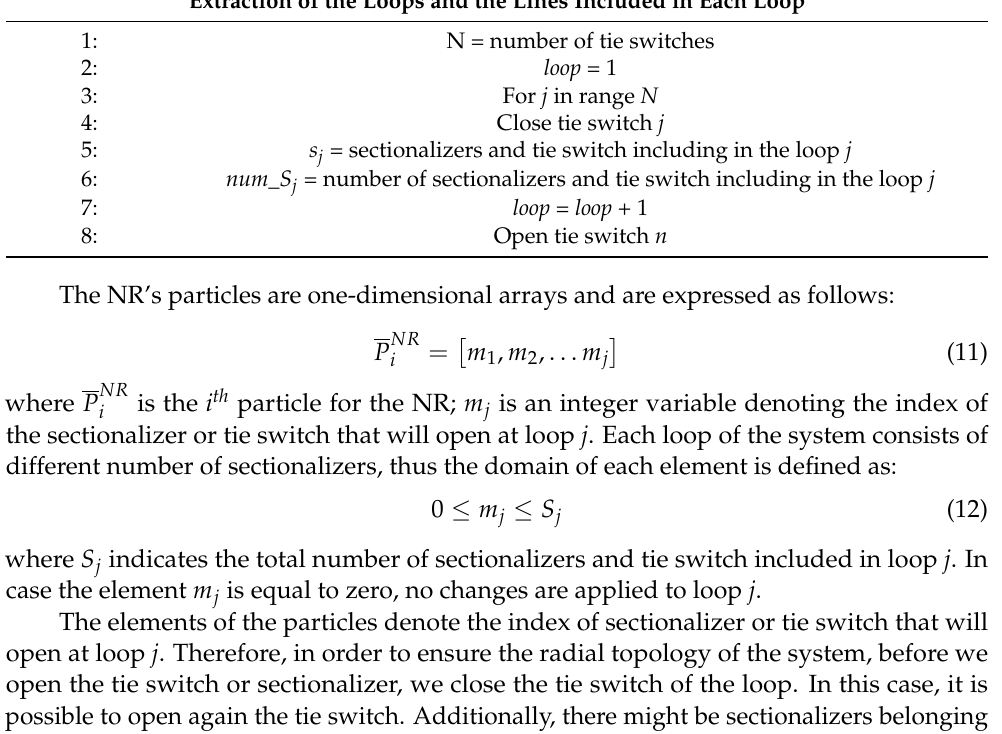
Table 3. Pseudocode for extraction of the loops and the lines included in each loop. Extraction of the Loops and the Lines Included in Each